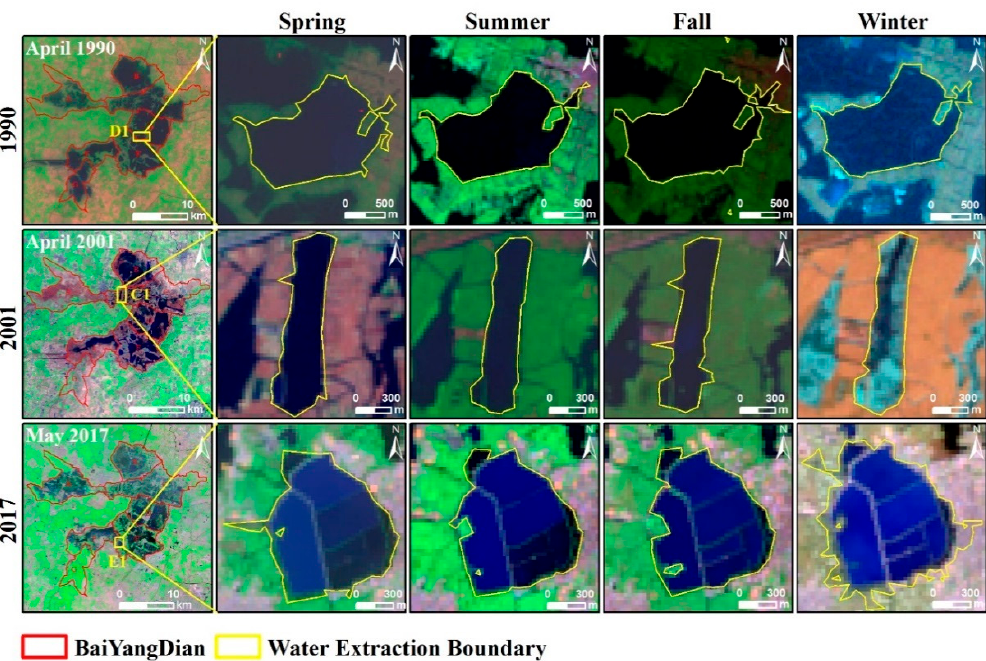
Figure 5. Seasonal verification of SMDPSO with selected data and sample areas. D1, C1, and E1 were the sample areas of 1990, 2001, and 2017, respectively. All images were displaced by false color images